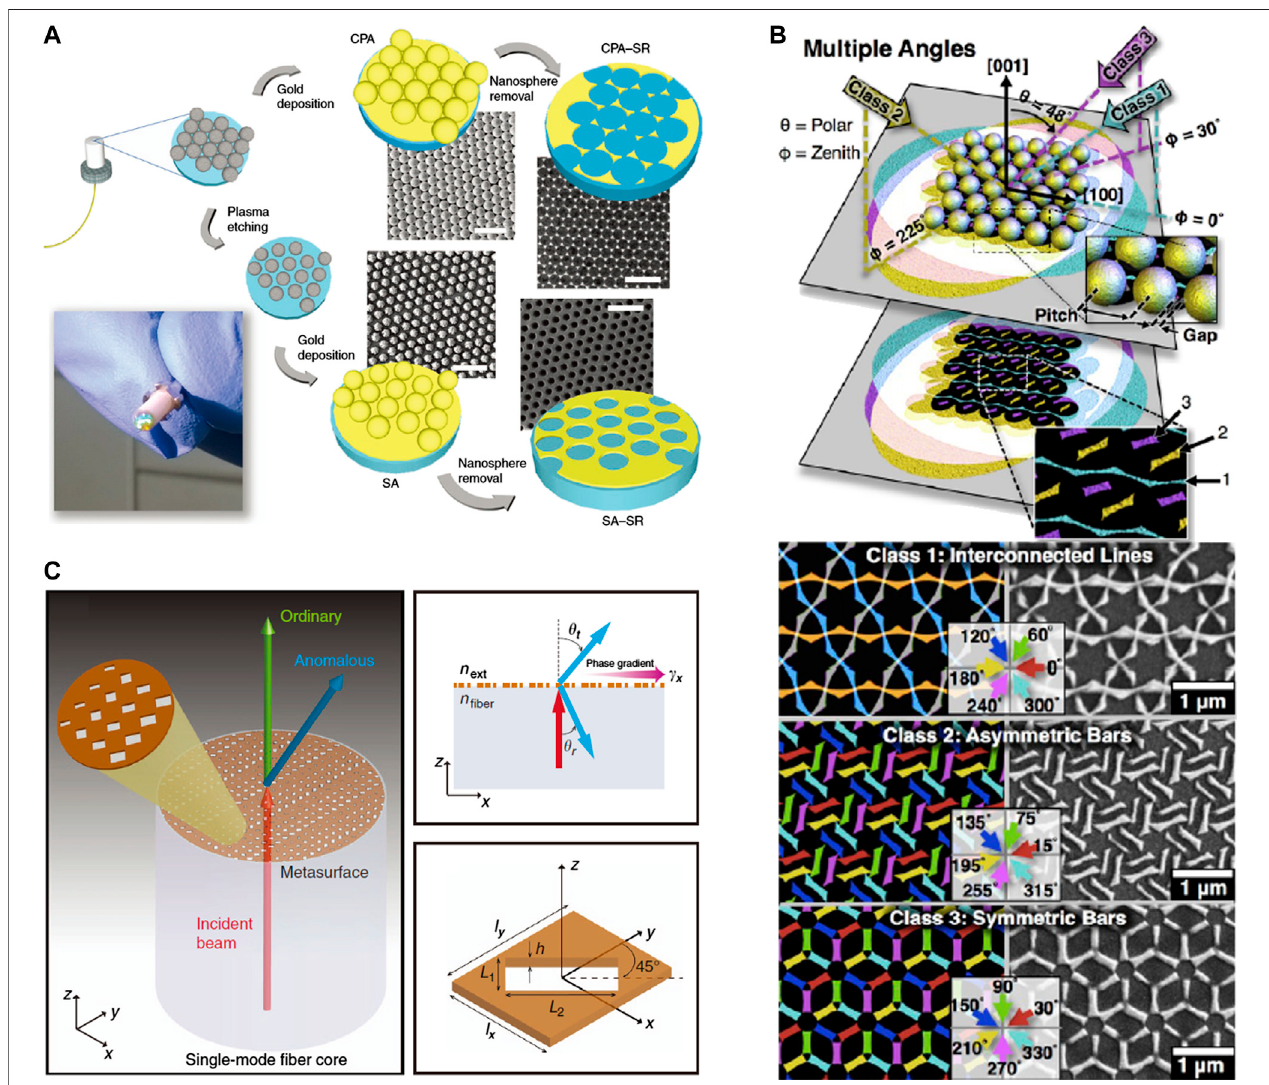
FIGURE10|(A) Fabricationprocessofmeta-structureonthe fi berend-facetviaself-assemblylithography[118]. (B) Meta-structuresfabricatedwithKaleidoscope shadow masks [110]. (C) Anomalous transmission on fi ber meta-tip [125]. Figure reproduced with permission from: (A) , © 2017, Nature Publishing Group (NPG); (B) , © 2014, American Chemical Society (ACS); (C) , © 2017, Nature Publishing Group